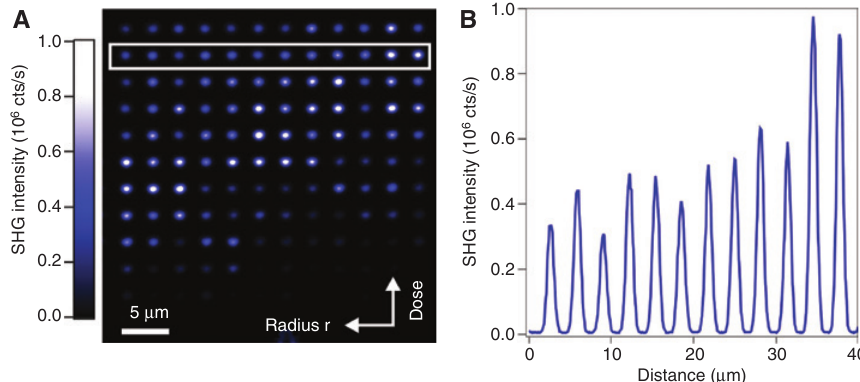
Figure 2: The nanodisks separation is about 3 micron, which sufficient to allow single-particle nonlinear microscopy. The SHG detection with silicon SPAD allows achieving a signal-to-noise ratio exceeding 10 4 . (A) SHG intensity map of an array of nanodisks with radius varying from 192 to 203 nm (from right to left) and increasing electron-beam lithography dose (from bottom to top). (B) Line profile of the SHG intensity along the second row of the array (see white box in